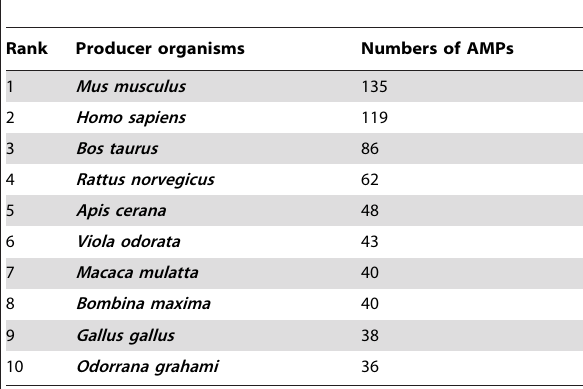
Table 1. Top 10 sources of the natural AMPs in LAMP.